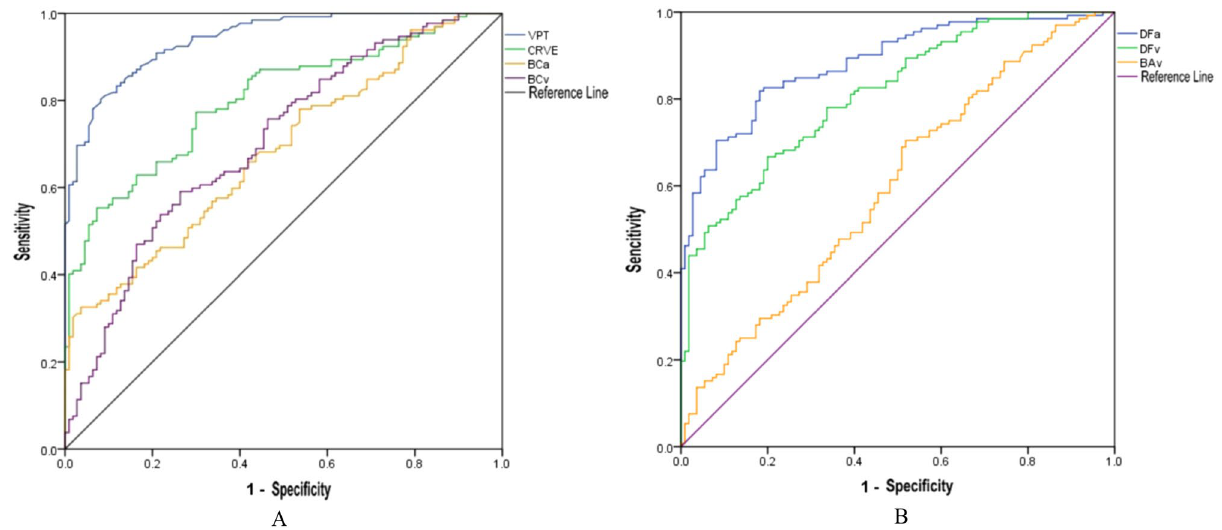
Figure 3. ROC curves for VPT, CRVE, BCa, BCv, DFa, DFv and BAv. ROC Receiver operating characteristics, VPT Vibration perception threshold, CRVE Central retinal vein equivalent, BCa Branching coefficient arterioles, BAv Branching angle veins, BCv Branching coefficient veins, DFa Fractal dimension arterioles, DFv Fractal dimension veins.